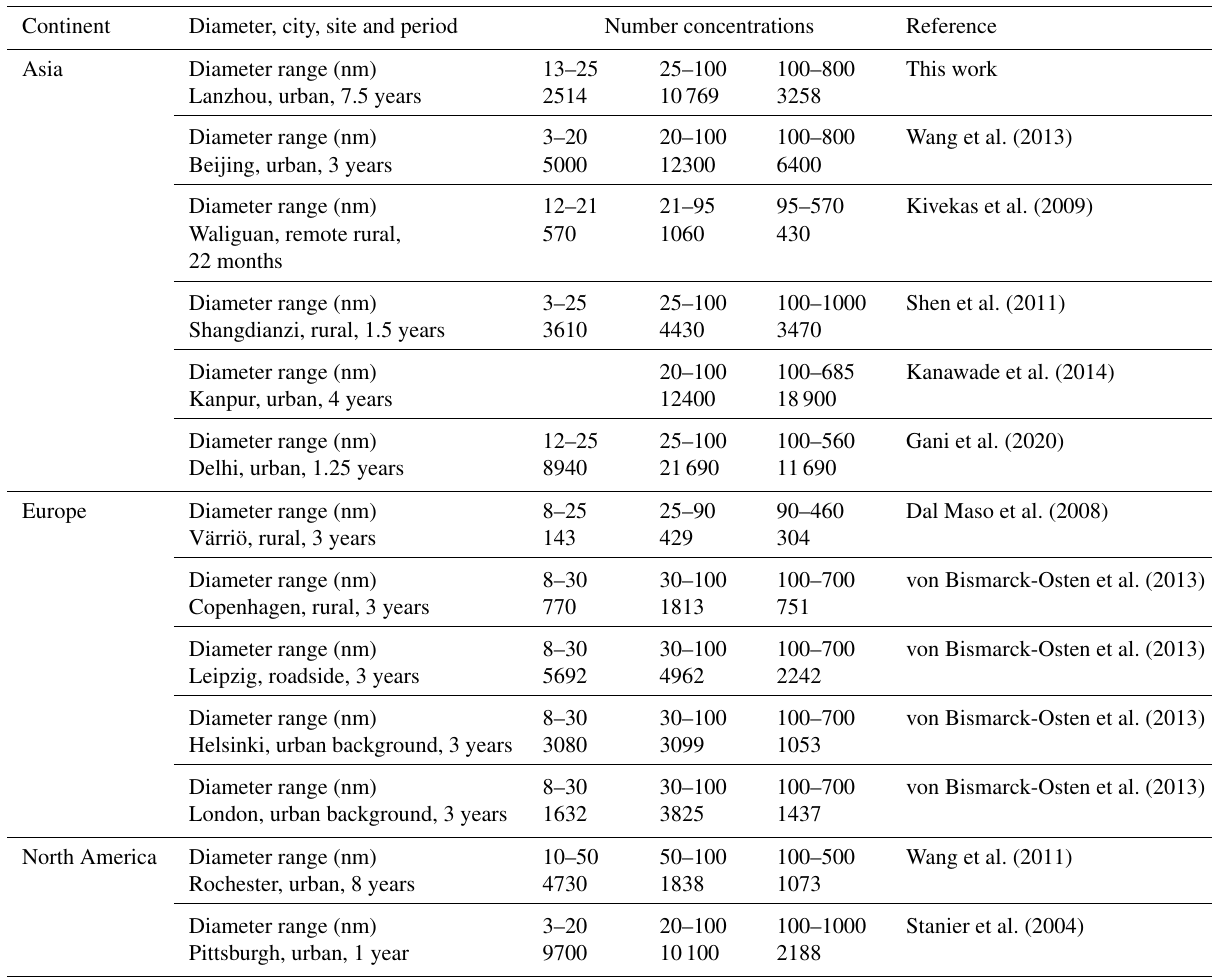
Table 1. Overview of experimentally determined particle number concentrations in the troposphere around the world. The duration of the measurement campaign was at least longer than 1 year (12